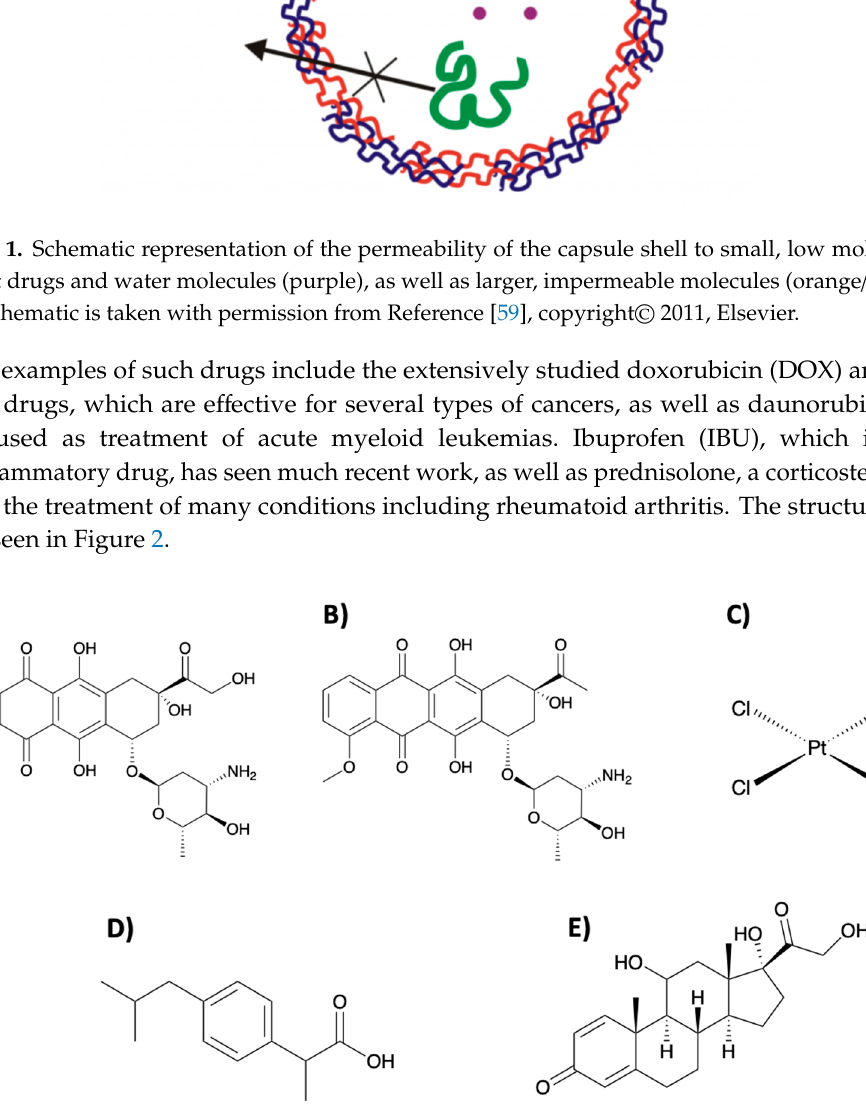
Figure 2. Molecular structures of ( A ) doxorubicin, ( B ) daunorubicin, ( C ) cisplatin, ( D ) ibuprofen, and ( E ) prednisolone.